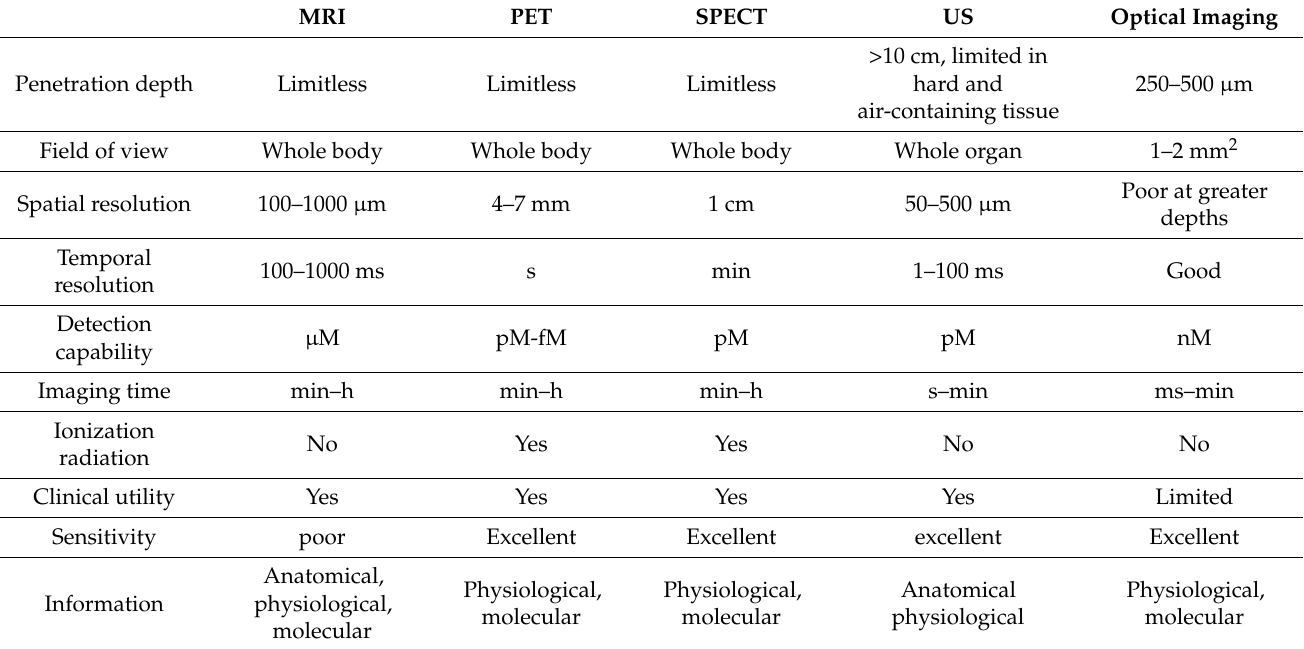
Table 1. Pros and cons of reporter gene brain imaging